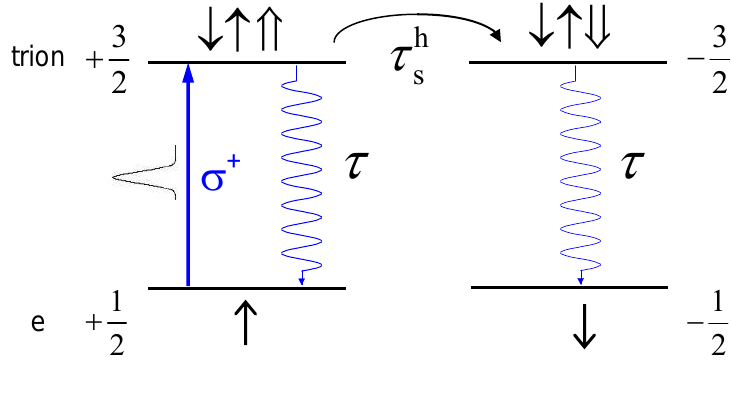
Figure 6. Excitation scheme of the electron spin generation in a negatively charged quantum dot under resonant trion excitation. ↑↓ electron spin; ,   , hole spin. τ , τ h recombination time and hole spin lifetime,